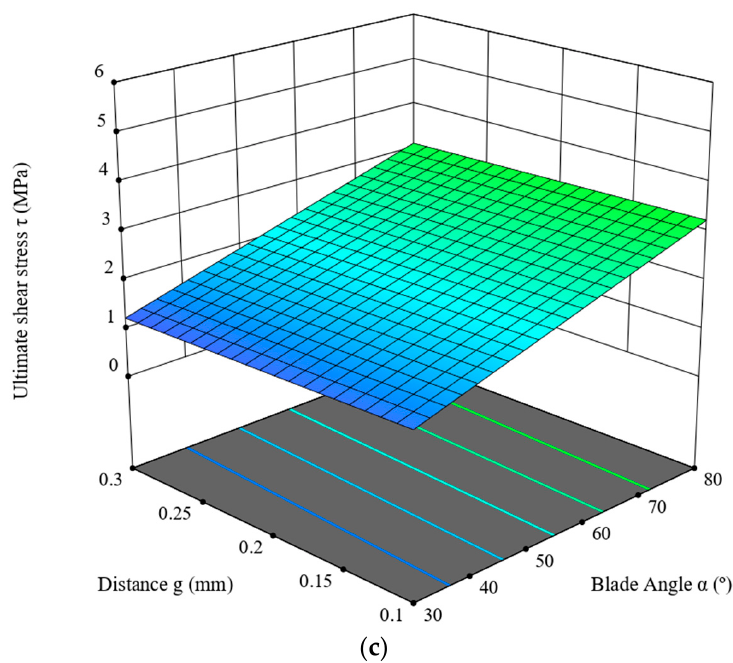
Figure 8. Ultimate shear stress, τ , in the function of the blade angle, α , of the distance, g, for velocity value ( a ) V = 1 mm/s, ( b ) V = 4 mm/s and ( c ) V = 8 mm/s. value ( a ) V = 1 mm/s, ( b ) V = 4 mm/s and ( c ) V = 8